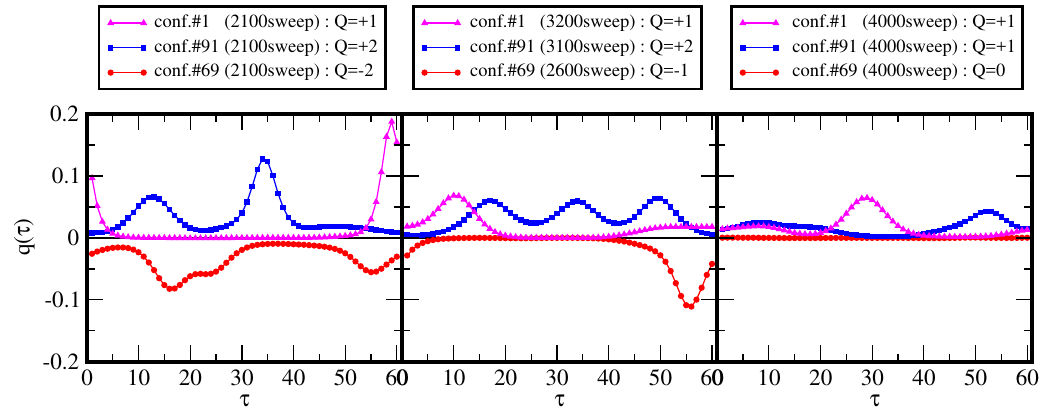
Figure 6 . Example of the sweep dependence of the local topological charge ( q ( (cid:28) )). The magenta- triangle, blue-square, and red-circle symbols denote the confs. #1 ; #91, and #69,